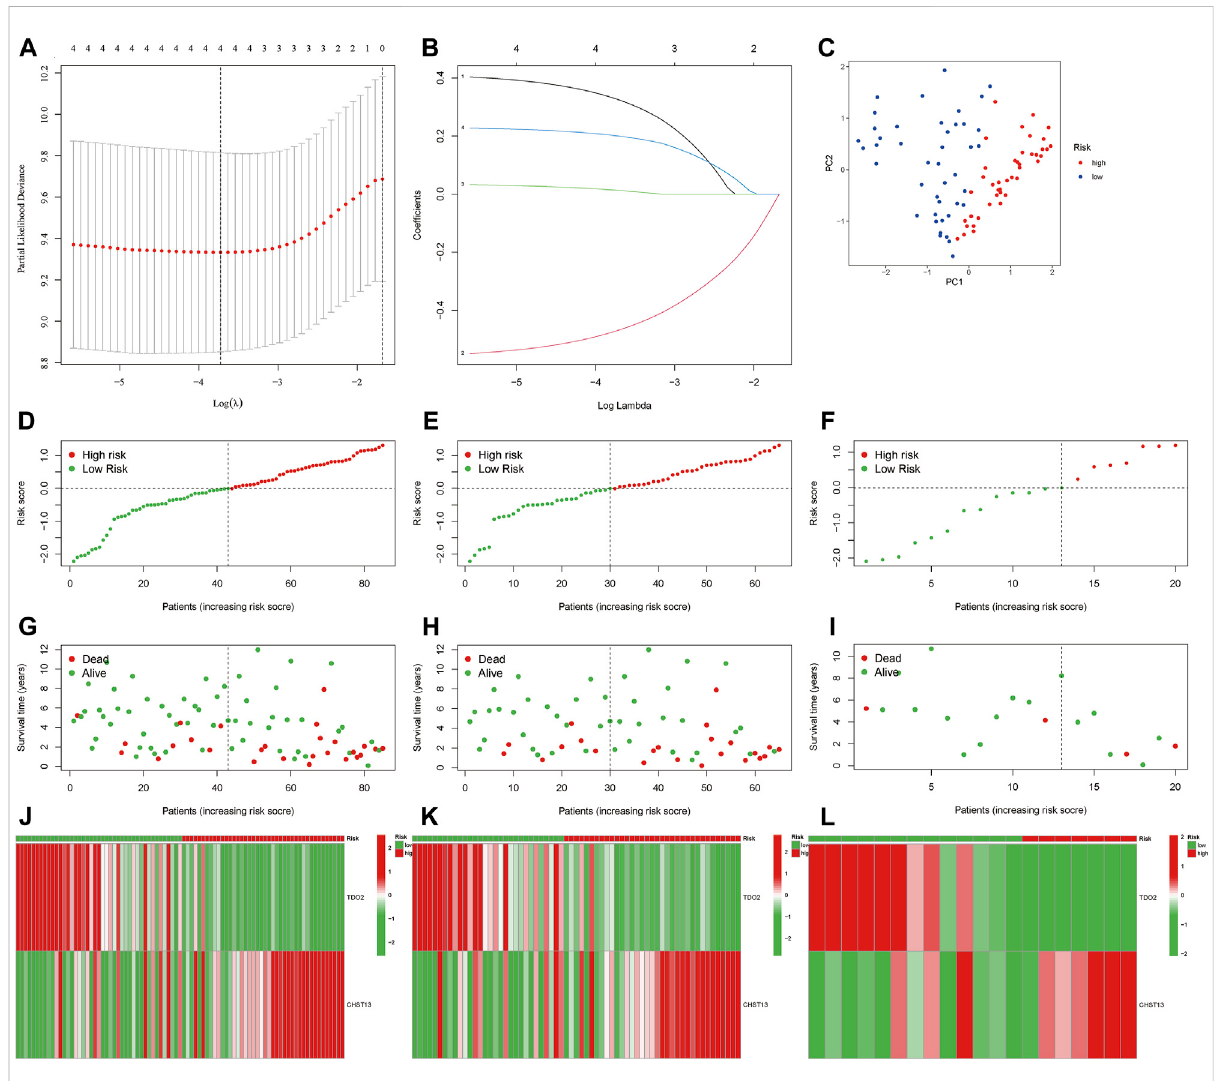
Establishment of prognosis signature. (A,B) The LASSO regression model was constructed. (C) PCA of OS samples according to the riskscore. (D – I) Thedistributionoftheriskscoreandsurvivalstatusofpatientsinthewhole,trainandtextcohort,respectively. (J – L) Theheatmapofdifferential expressions of two MRmetabolism between high-risk and low-risk